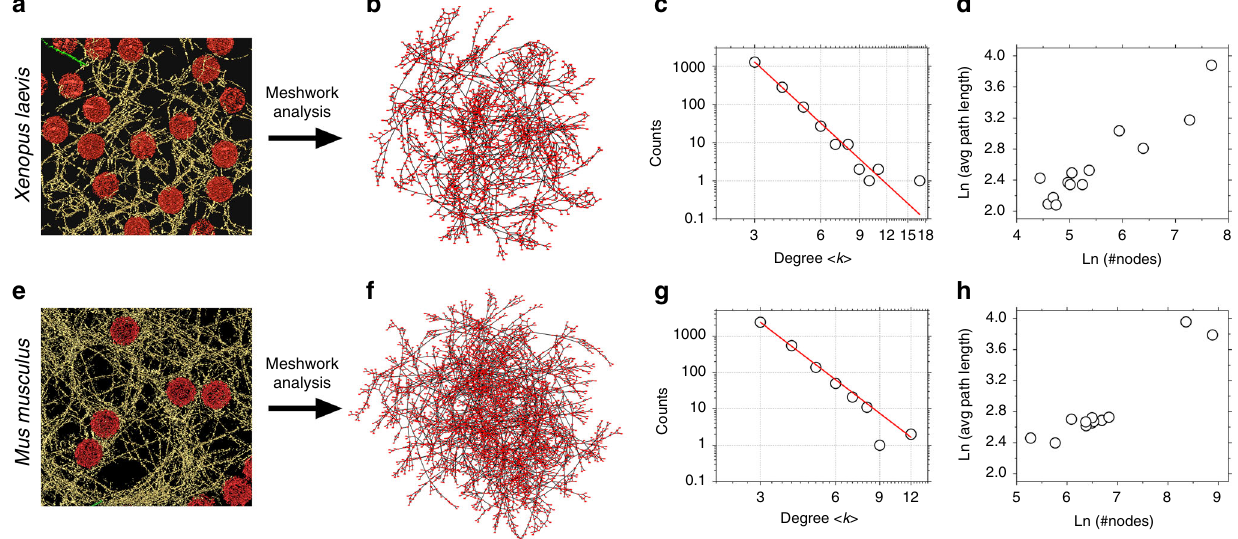
Fig. 5 Nuclear lamin meshworks of X. leavis oocyte and mouse embryonic fi broblast show similar topology. The 3D lamin meshworks as viewed by cryo- ET of a X. laevis oocyte NE ( n = 13 tomograms) ( fi eld of view, 700 nm × 700 nm) (Fig. 1b) and e MEF NE ( n = 12 tomograms) (adapted from ref. 4 ; fi eld of view, 1000 nm × 1000 nm) were analyzed to create undirected graphs ( b , f ). Nuclear lamins formed a 3D meshwork of fi laments (yellow) connected to NPCs (red). The red dots in the graphs denote the nodes or the vertices (coordinates of fi lament interactions or crossovers) de fi ned as the points where adjacent lamin fi laments (gray connecting lines) appeared closer than 1.3 nm. c , g Degree distribution of both the lamin meshworks revealed a power-law behavior with an index λ ≈ 5.6, and d , h exhibited “ small-world ” characteristics where the average path-lengths scale with the meshwork